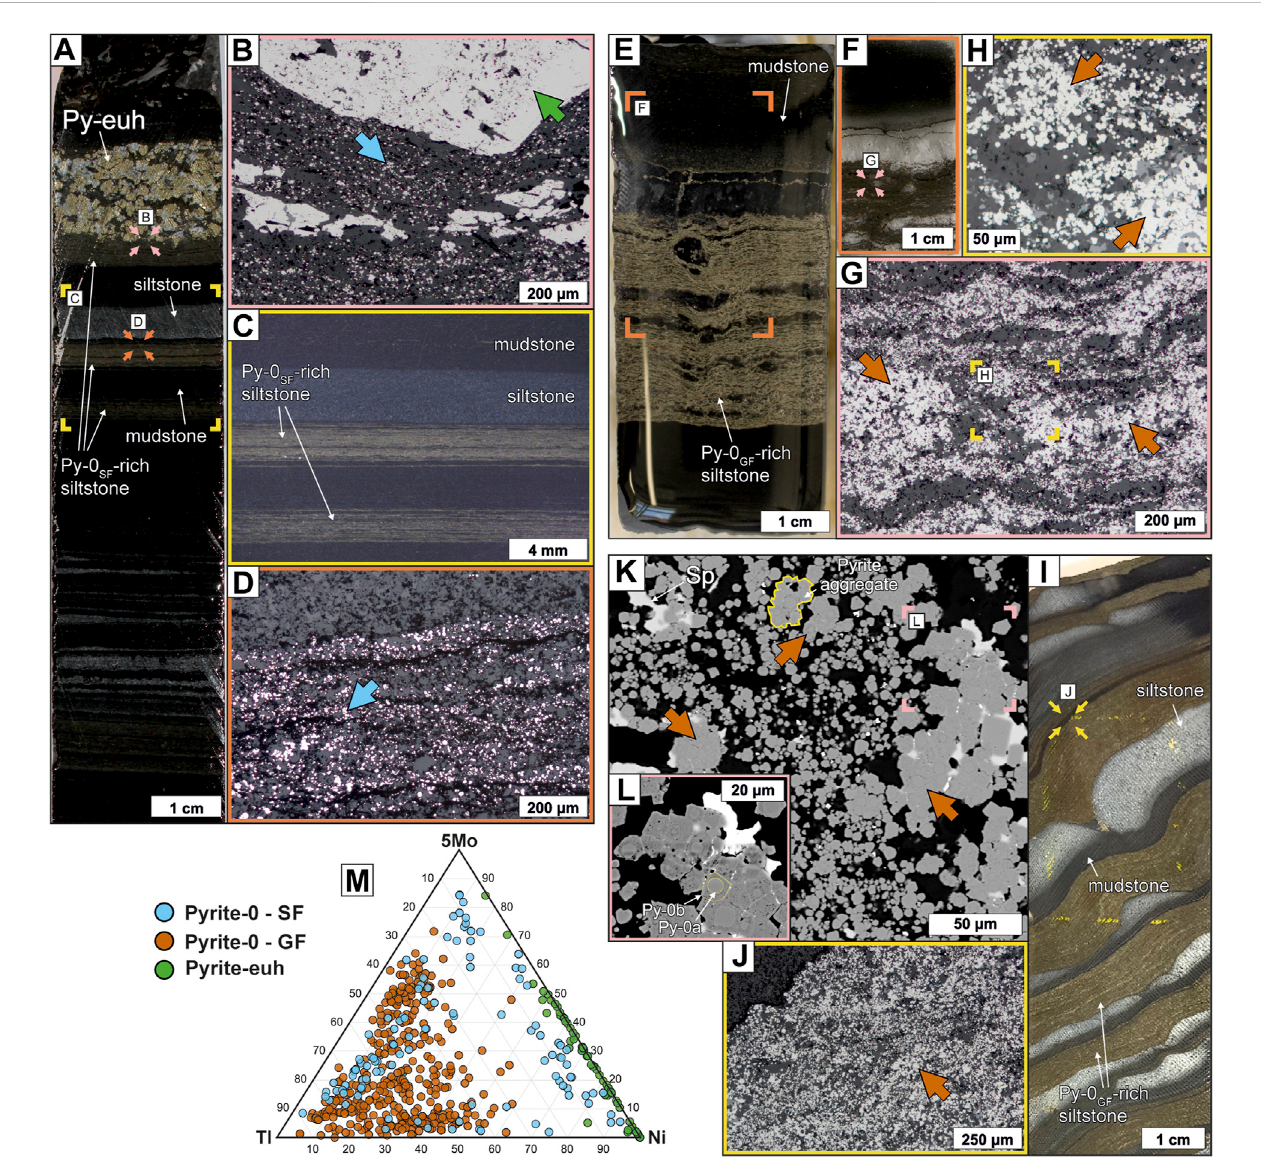
FIGURE 4 Urquhart Shale samples containing abundant fi ne-grained Py-0 [Shovel Flats drill-core: (A – D) , George Fisher deposit: (E – L) ]. (A) A hand specimen photograph of sample PR832SF040 containing Py-0 SF -rich (Py-0 from the Shovel Flats drill hole) laminae and Py-euh. The coloured rectangles and arrows denote the location of (B – D) . (B) A re fl ected light photomicrograph of Py-0 SF (blue arrow) and Py-euh (green arrow). (C) A binocular photomicrograph of laminated siltstone with abundant Py-0 SF . (D) A re fl ected light photomicrograph of Py-0 SF (blue arrow). (E) A hand specimen photograph of sample PRK7952023containingPy-0 GF .Theorangerectangledenotesthelocationof (F) . (F) AphotographofathinsectionofsamplePRK7952023containingPy-0 GF (dark brown laminae). The pink arrows denote the location of (G) . (G) A re fl ected light photomicrograph of Py-0 GF (brown arrows), which is present in individual grainsand grain aggregates. The yellow rectangle denotes the location of (H) . (H) A re fl ected light photomicrographof Py-0 GF (brown arrows). (I) A hand specimen photograph of sample PRK751003 containing laminated, carbonaceous Py-0 GF -rich siltstone (brown with yellow striations), calcite- and dolomite-cemented siltstone (light grey to white), and carbonaceous mudstone (dark grey to black). The yellow arrows denote the location of (J) . (J) A re fl ected light photomicrograph of abundant Py-0 GF (Py-0 at George Fisher) in laminated siltstone. (K) A backscatter electron photomicrograph of Py-0 GF (brownarrows)andminorsphalerite(Sp).Pyrite-0 GF iseitherpresentinindividual grainsorgrain aggregates.Thepinkrectangledenotesthelocationof (L) . (L) A backscatter electron photomicrograph of a Py-0 GF aggregate. Note the zonation of individual grains with spheroidal to sub-spheroidal cores (Py-0a) and euhedral to subhedral overgrowths (Py-0b). (M) A ternary diagram of Tl, Ni, and 5*Mo abundances for Py-0 SF , Py-0 GF , and